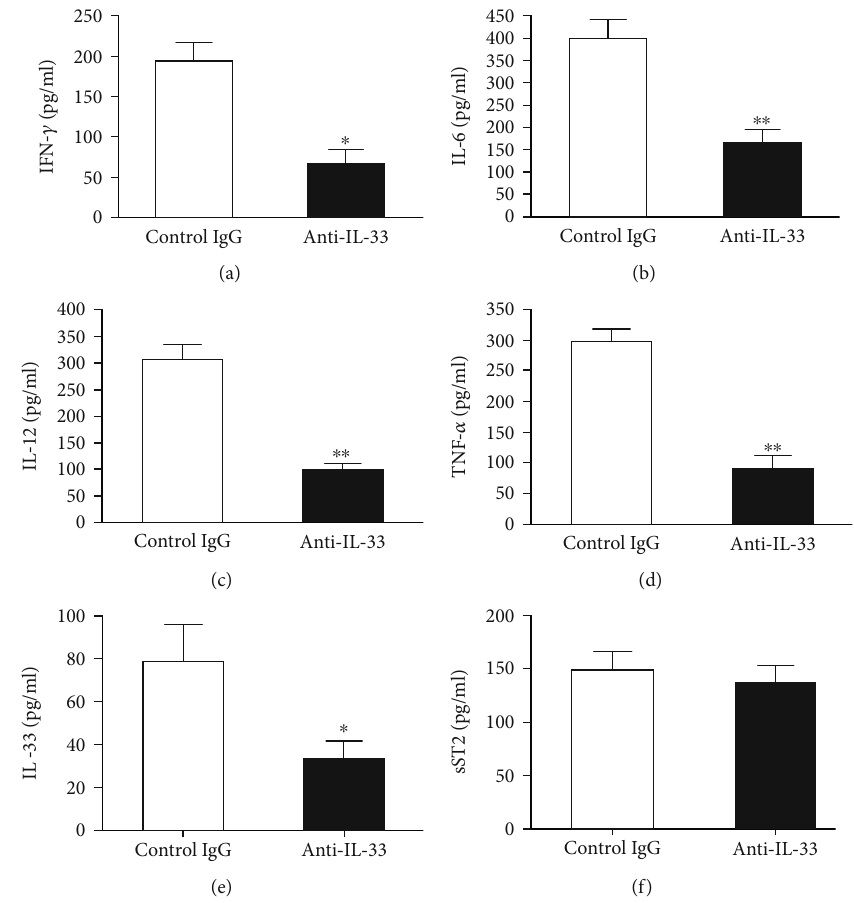
Figure 4: E ff ect of anti-IL-33 on serum proin fl ammatory cytokine production. Mice treated with anti-IL-33 or control IgG were killed on day 43, and the serum was collected from eight mice in each group. Levels of IFN- γ (a), IL-6 (b), IL-12 (c), TNF- α (d), IL-33 (e), and sST2 (f) were determined by ELISA. Data are mean ± SEM ( n = 8 ); ∗ p < 0 : 05 , ∗∗ p < 0 : 01 vs. the control IgG group by two-tailed unpaired Student ’ s t